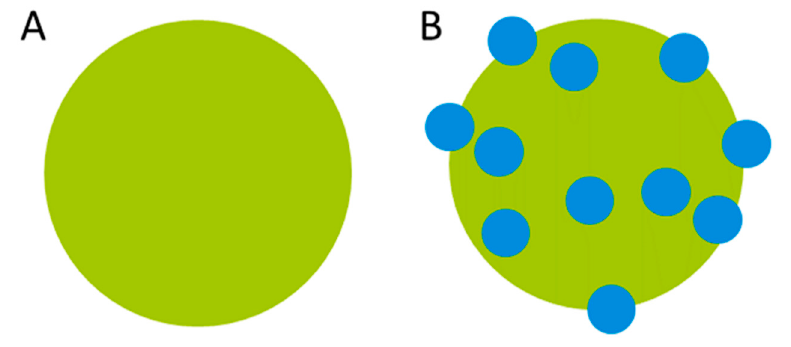
Figure 2. ( A ) P25 ‐ TiO 2 NM; ( B ) P25 ‐ TiO 2 NM decorated (coated) with Cu 2 O NMs. Figure 2. ( A ) P25-TiO 2 NM; ( B ) P25-TiO 2 NM decorated (coated) with Cu 2 O